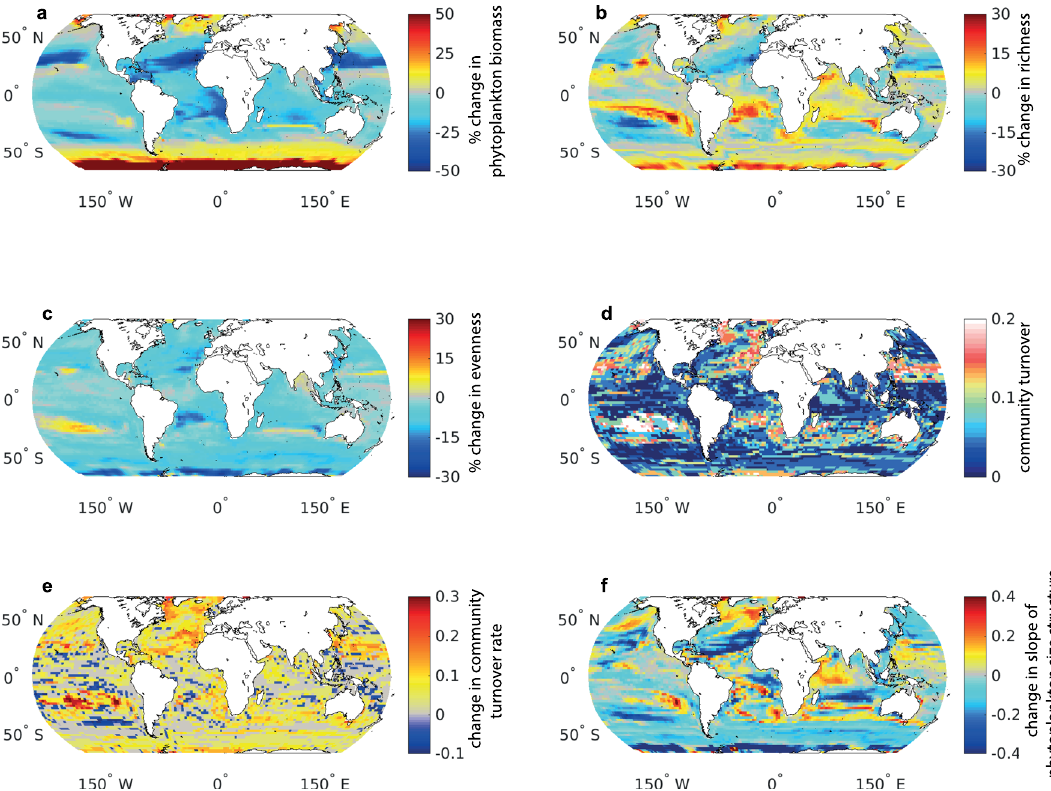
Fig. 1 Change in phytoplankton community structure by the end of the century. For subplots a – d , f the change between the baseline period (mean of 2005 − 2024) and end of the century (mean of 2081 − 2100) is shown. a Percent change in total phytoplankton biomass; b percent change in richness; c percent change in evenness; d community turnover; e change in community turnover rate (turnover between the mean of 2061 − 2080 and 2081 − 2100 minus mean of 2011 − 2030 and 2031 − 2040); f change in slope of the phytoplankton community size structure, where negative values indicate a greater abundance of small phytoplankton